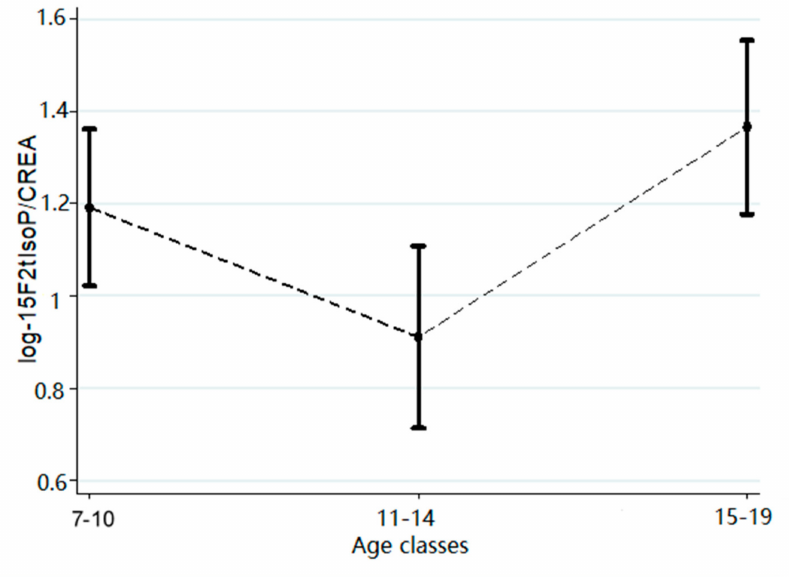
Figure 2. Margins plot of the relation between log 15F2t–IsoP and age